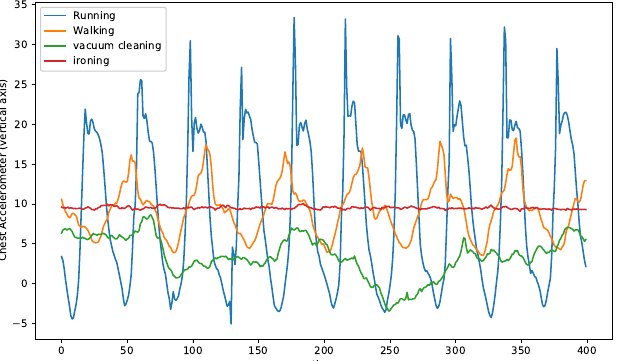
Figure 2. Comparison among three activities from PAMAP2